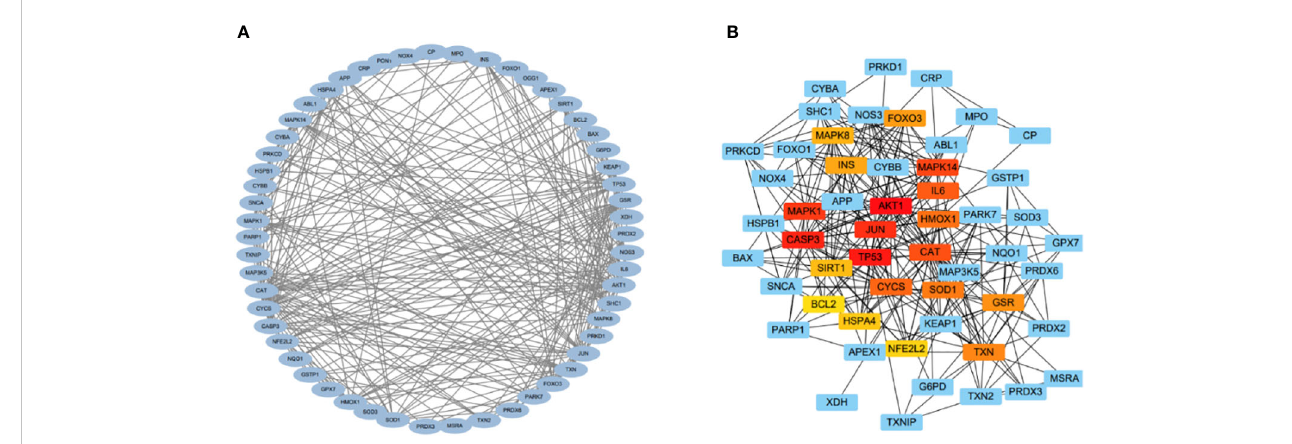
FIGURE 4 PPI and hub gene networks. (A) PPI network; (B) Hub gene